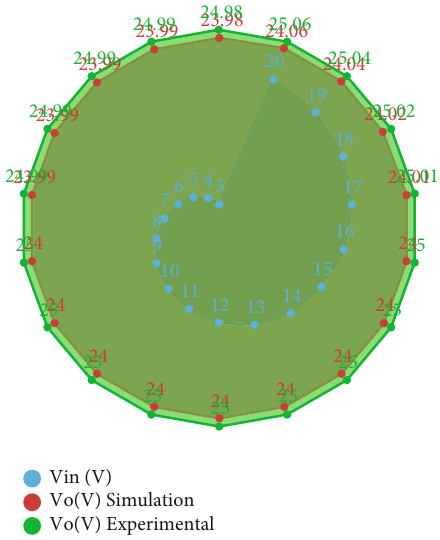
Figure 20: Graphical numerical simulation and experimental analysis of V